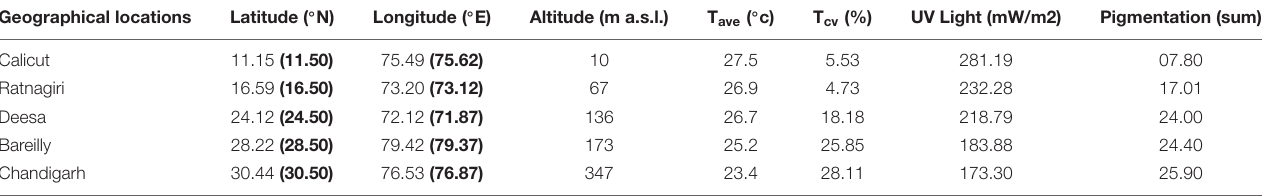
TABLE 1 | Geographical and climatic data for the five locations of the origin of the populations of D. melanogaster from the Indian subcontinent. Geographical locations